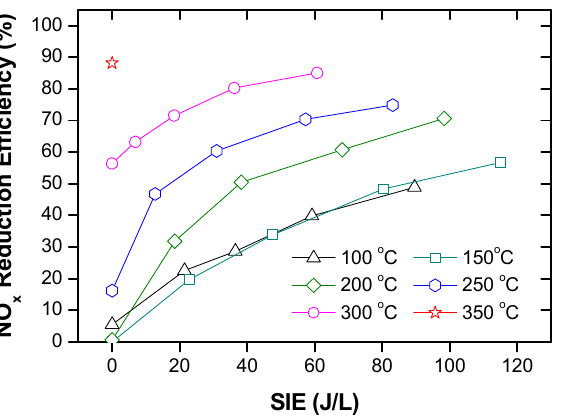
Figure 15. NO x removal as a function of temperature and ED in a packed-bed DBD reactor. It adopted from Reference [102], with permission from Elsevier.